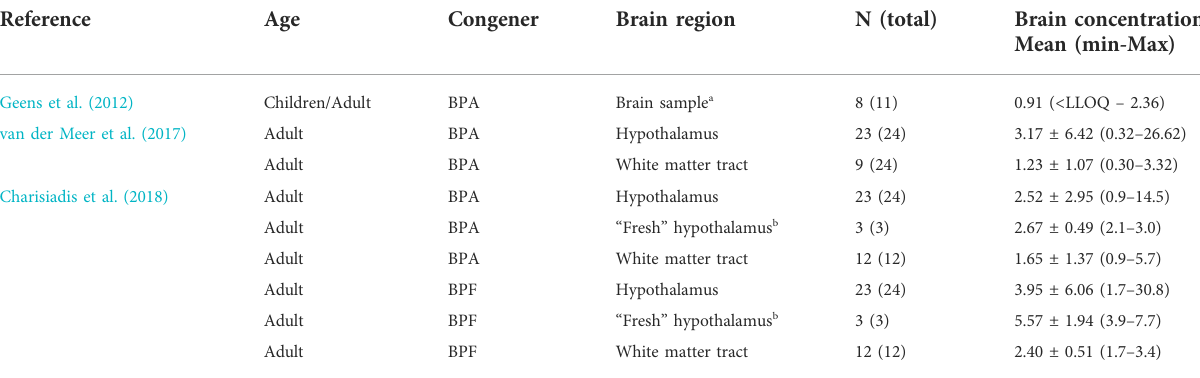
TABLE 5 Concentrations of bisphenols in human